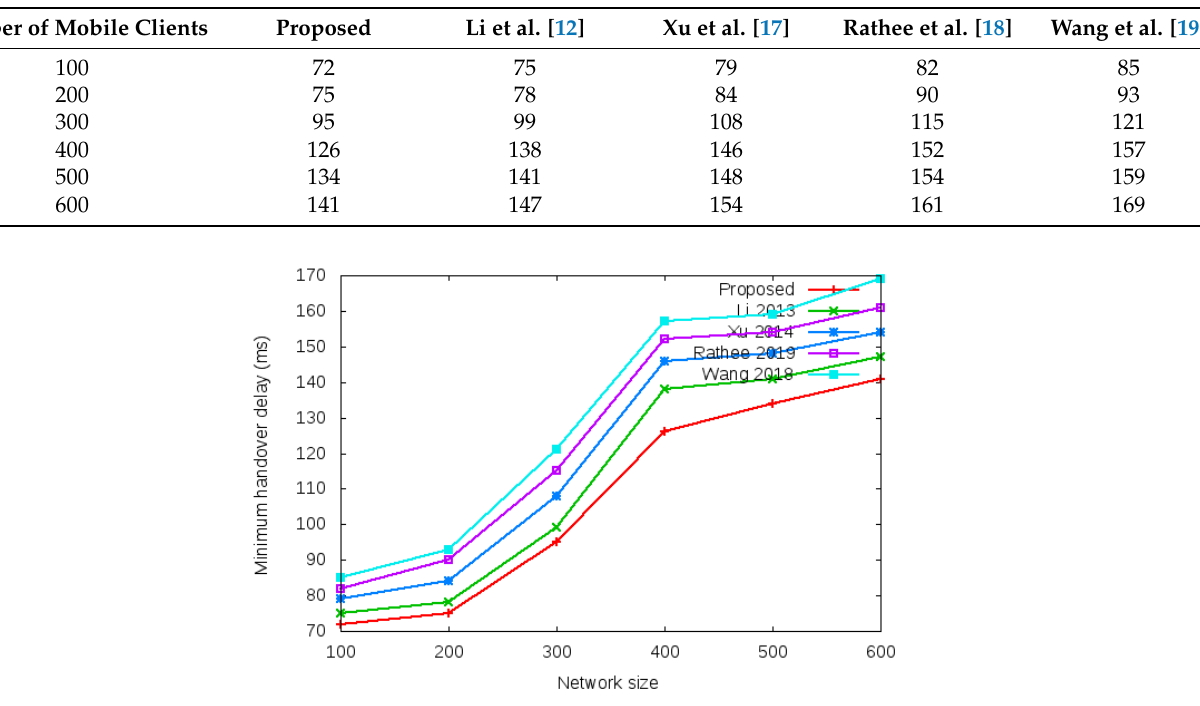
Table 8. Comparison on minimum handover authentication delay.